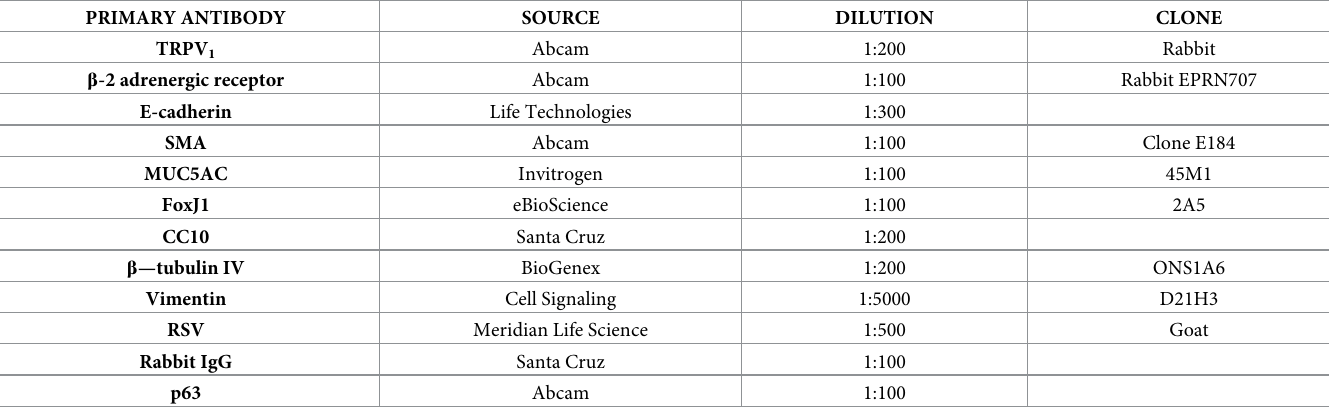
Table 1. Primary antibodies used for immunofluorescence experiments. PRIMARY